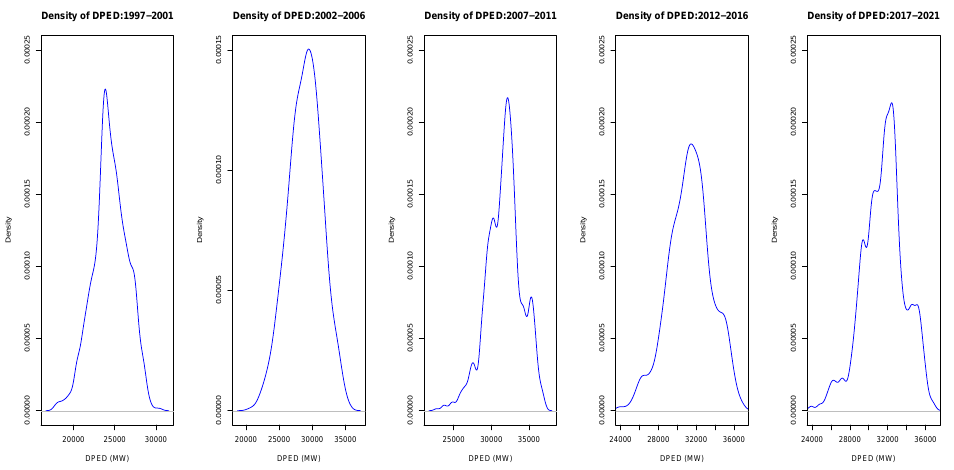
Figure 9. Distributions for the DPED for every five